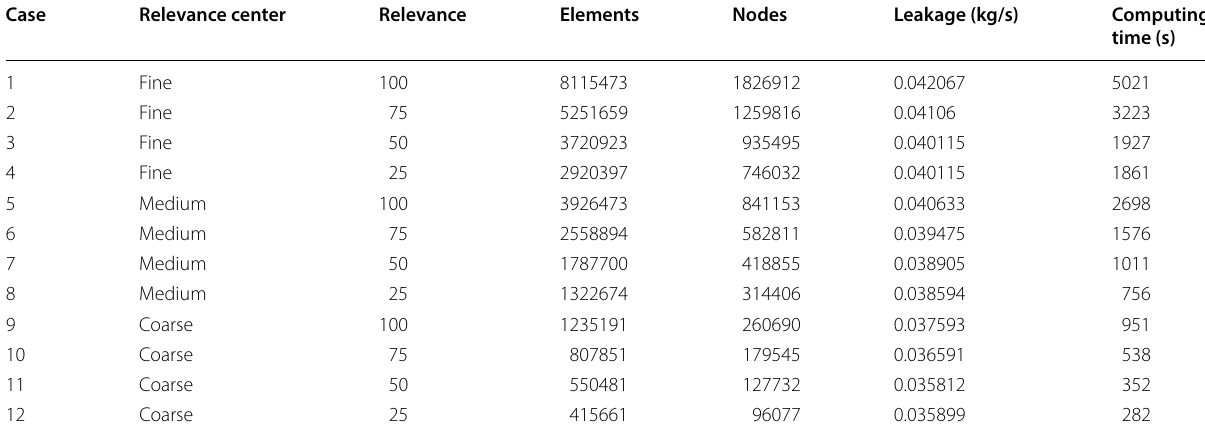
Table 4 Computational mesh comparison